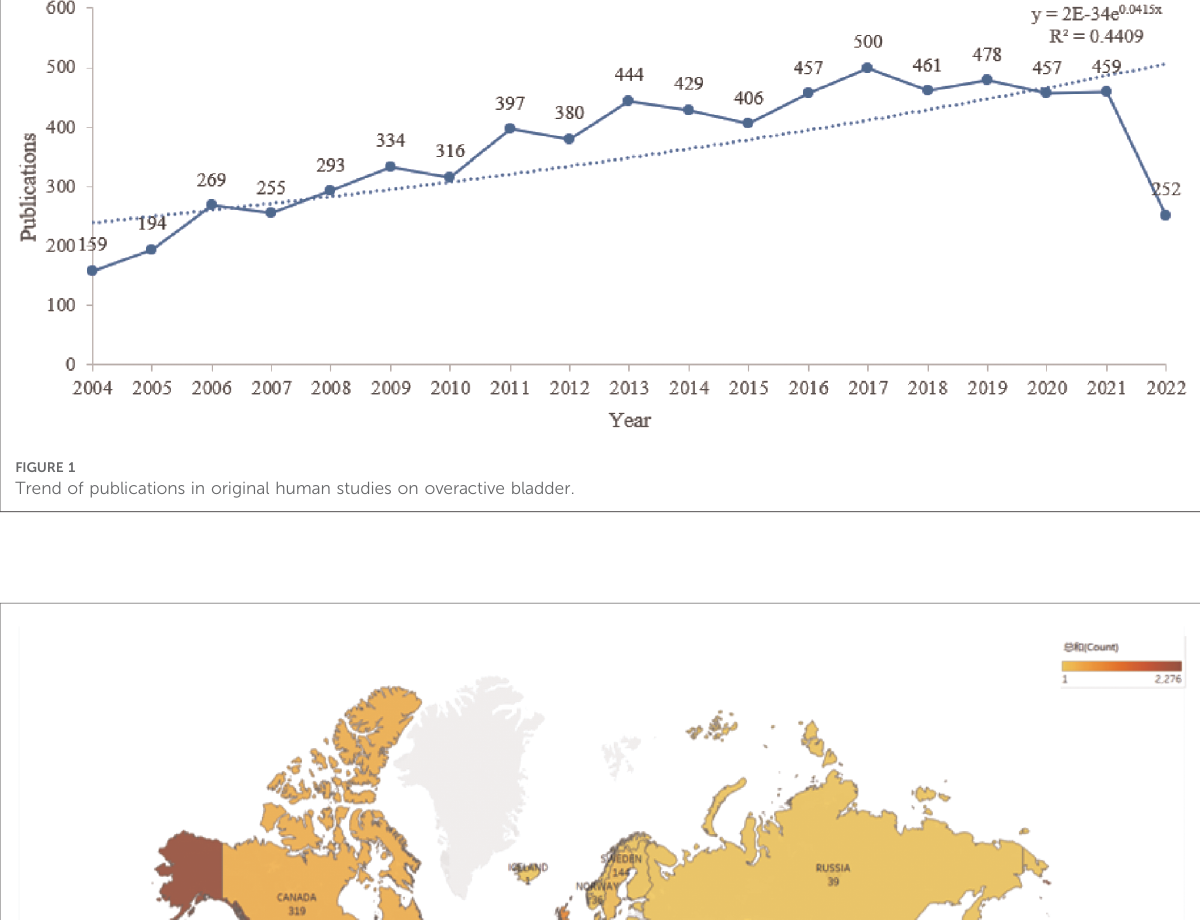
showing that more articles were published on OAB by the US in recent years. The cooperative relationship between countries could also be observed. The US has the largest number of publications, and other countries had a strong cooperative relationship with the US ( Figure 5 ).